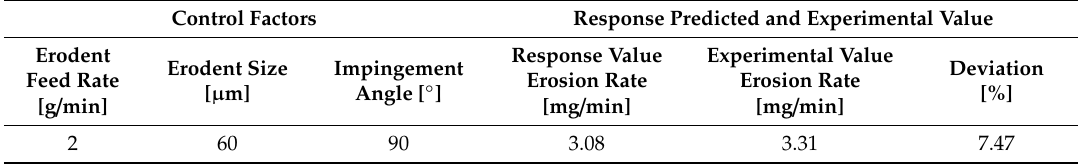
Table 10. Process variables setup (minimum Erosion rate ), predicted response value, and experimental